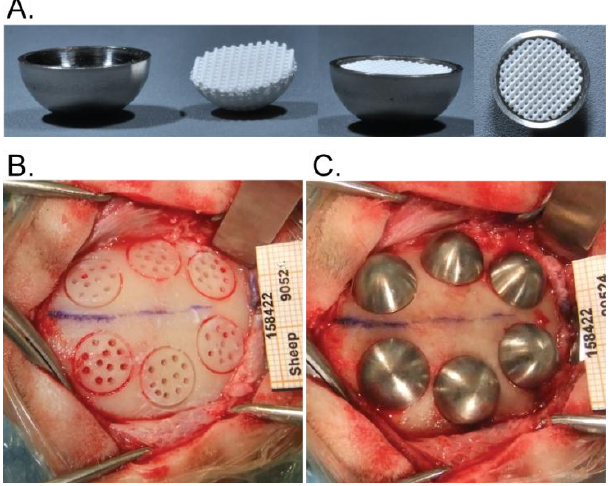
Figure 1. ( A ) Titanium hemispheres filled with 3D printed construct; ( B ) circular